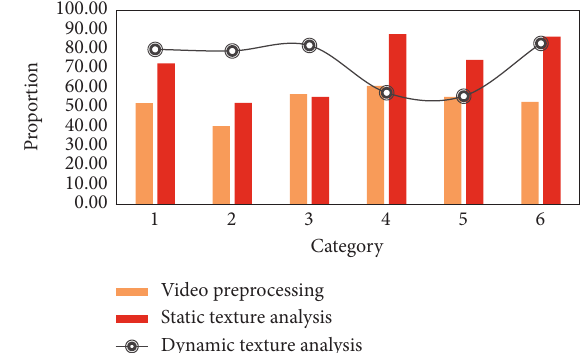
Figure 3: System time complexity